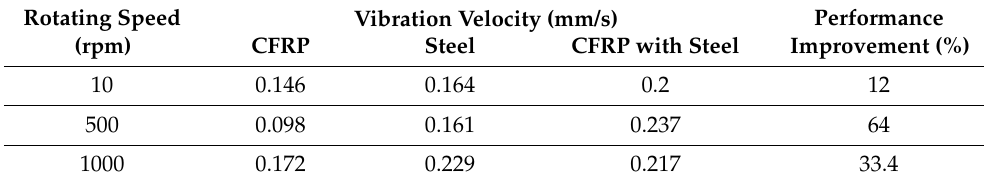
Table 9. Vibration velocity of fastening part.